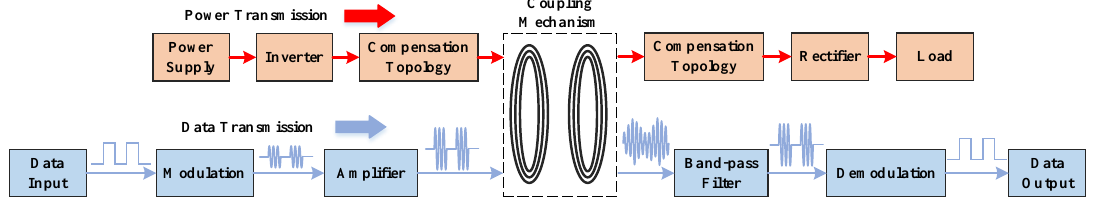
Figure 1. Data and power transmission achieved by power transfer coils.